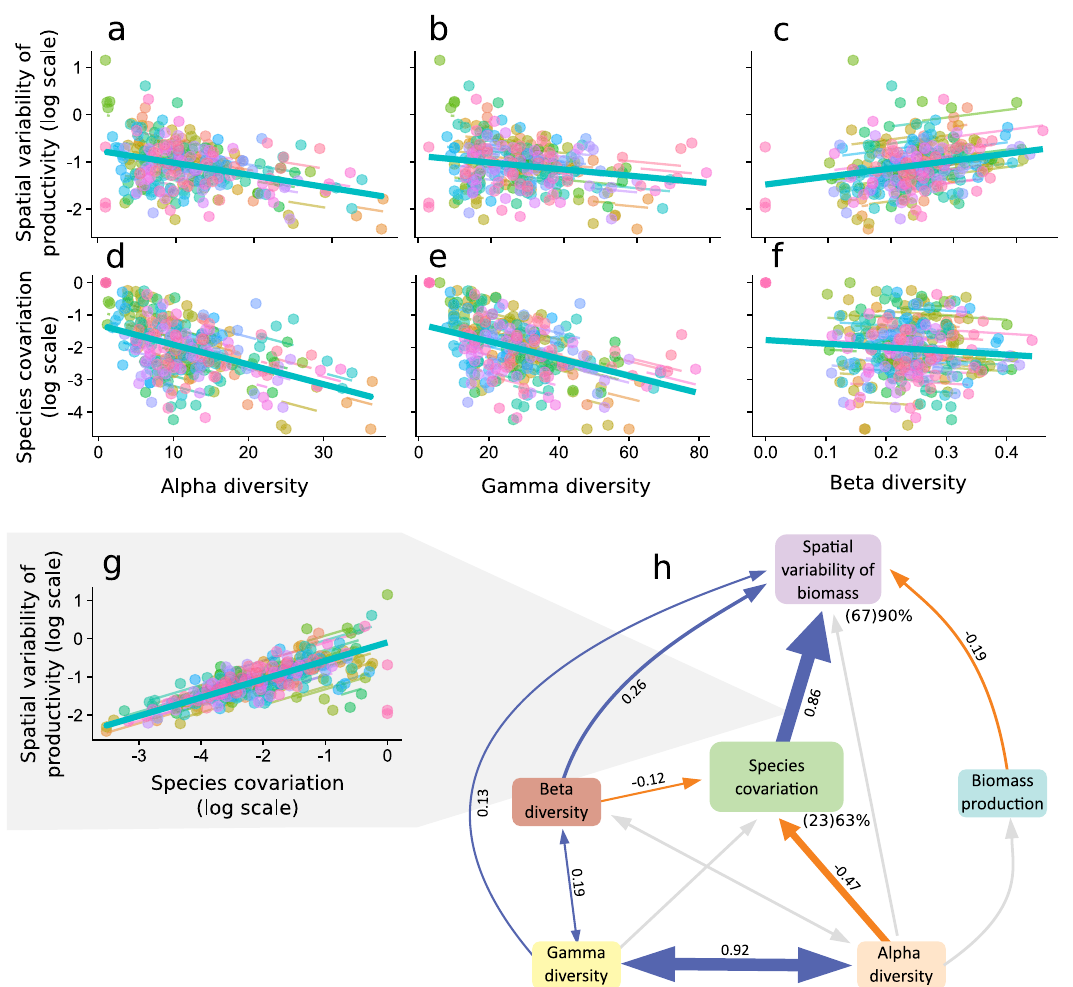
Fig.3|Therelationshipsbetweenplantspeciesdiversityandspatialvariability of productivity across 83 globally distributed grasslands sites of the Nutrient